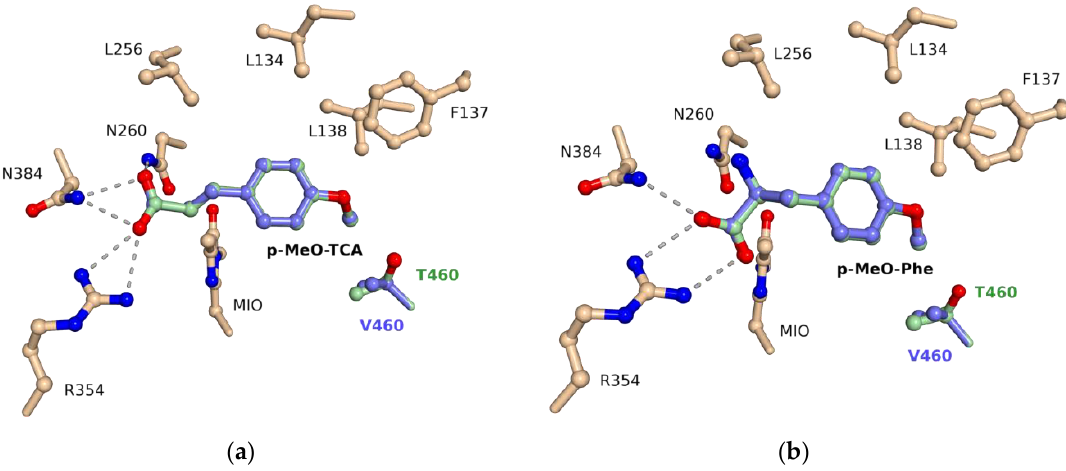
Figure 6. View of the catalytic site, including the electrophilic 4-methylideneimidazol-5-one (MIO) prosthetic group; overlay of the ( a ) p -MeO cinnamic acid and ( b ) p -MeO-Phe orientations within the catalytic site of I460V and I460T.